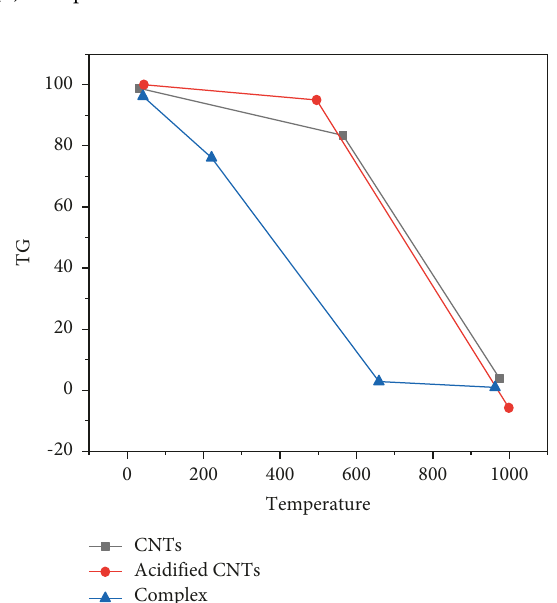
Figure 2: (a) CNTs. (b) Complex.